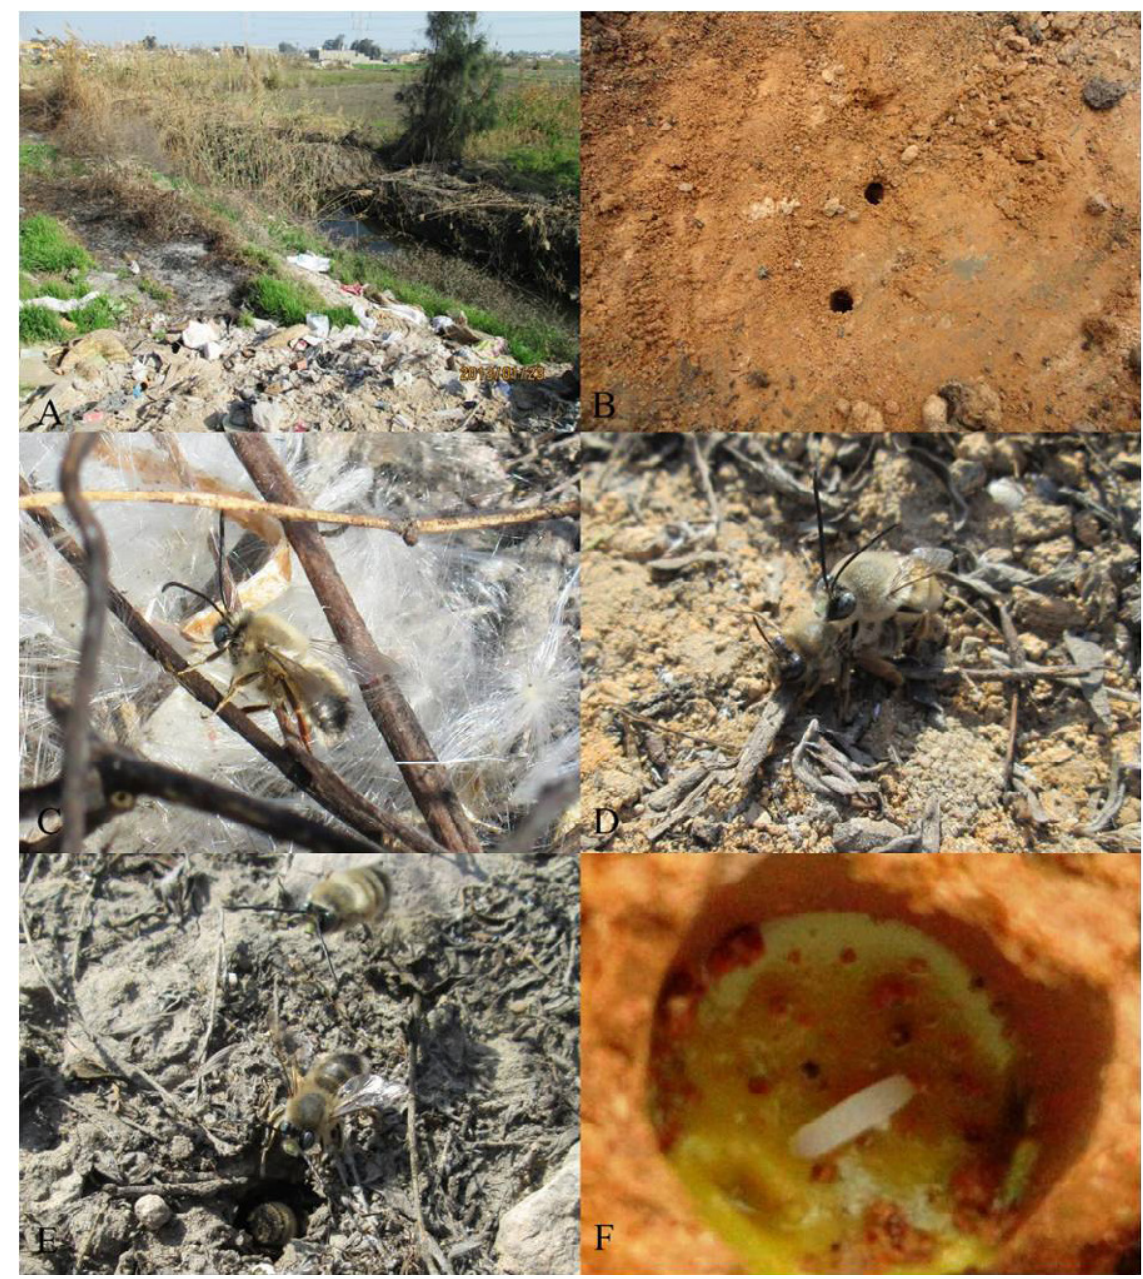
Fig 2 . A. Nesting site area; B. Nest entrance; C. Mature male of the resting site; D. Mating, E. Nesting activities, F. The